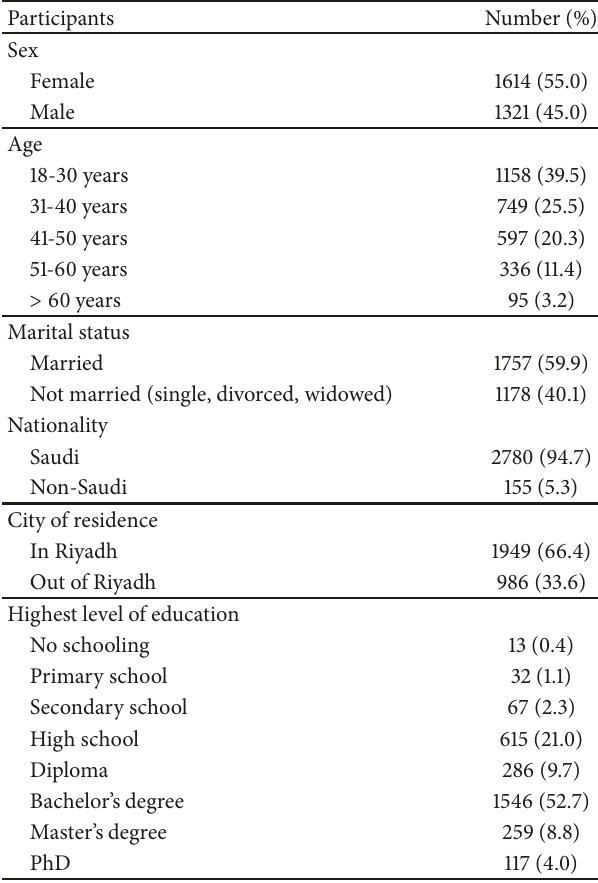
Table 1: Characteristics of the study population (total number of participants